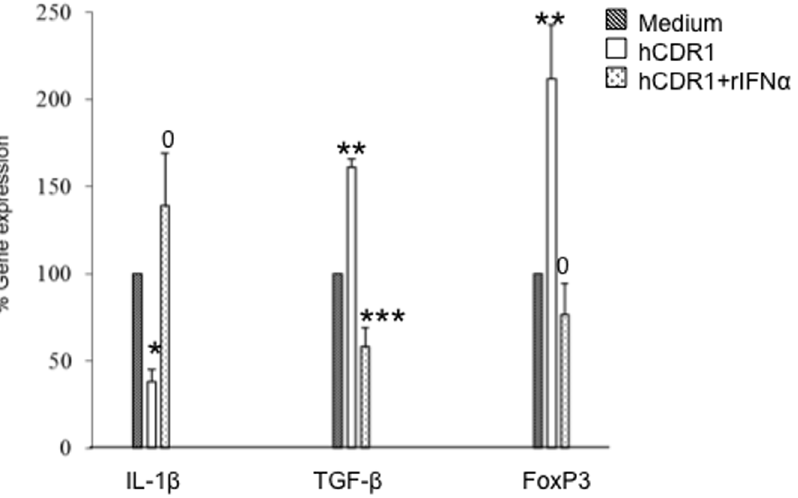
Figure 5. IFN- a diminishes hCDR1 immunomodulatory effects on PBMC of SLE patients. PBMC of 3 SLE patients were cultured (5 6 10 6 cells/well) for 48 hours in the presence of medium, hCDR1 (25 m g/ml) or hCDR1 (25 m g/ml) and human recombinant IFN- a (rIFN- a ) at a concentration of 5,000 U/ml. Gene expression (for IL-1 b , TGF b and FoxP3) were determined by real-time RT-PCR. Results are presented as the mean 6 SEpercentage of gene expression compared with cultures of PBMC incubated with medium alone (considered as 100%). *p=0.05, **p=0.03, ***p=0.015 and 0 =not significant. doi:10.1371/journal.pone.0060394.g005 PLOS ONE |